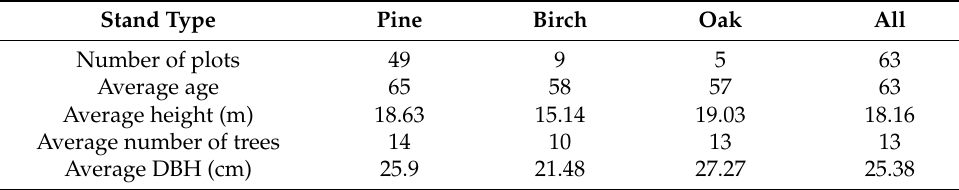
Figure 1. Location of sample plots around the capital of Poland—Warsaw.